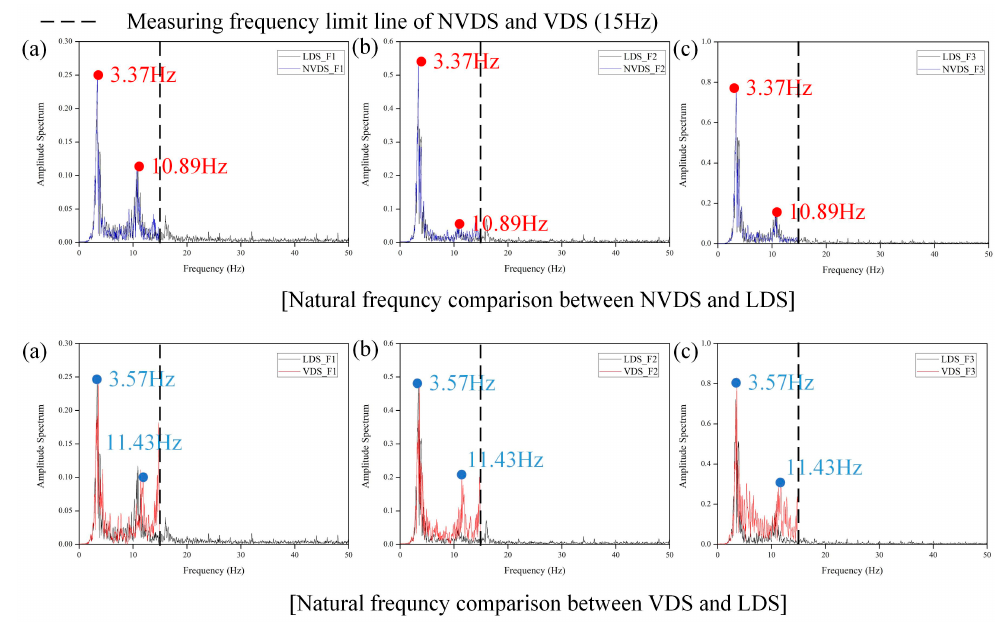
Figure 8. Comparison of natural frequency between LDS and NVDS and between LDS and VDS. ( a )